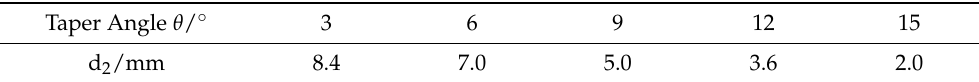
Figure 8. Structure diagram of a tapered header. ( a ) Schematic diagram, ( b ) local structure. Table 3. Structural parameters of the tapered header.